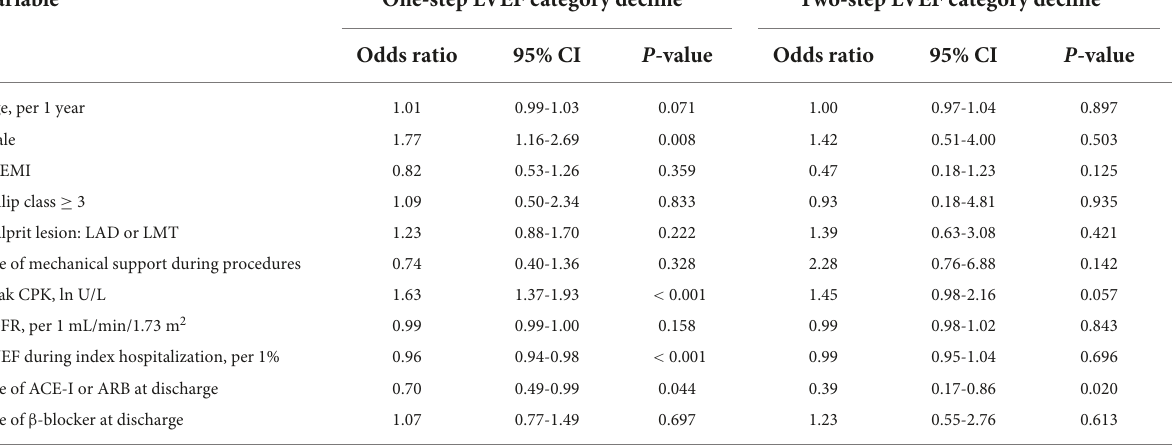
TABLE 3 Logistic regression analysis to identify clinical factors associated with a decline in LVEF category over the 6 months after AMI. Variable